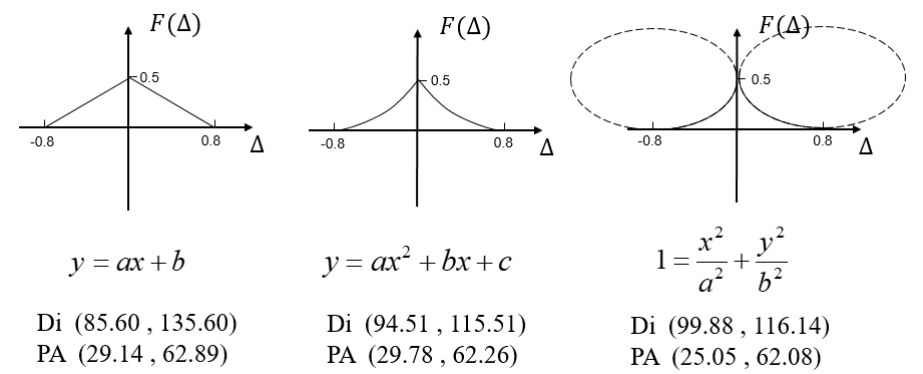
Figure 9. Adaptive function F ( ∆ ) and adaptive sampling interval